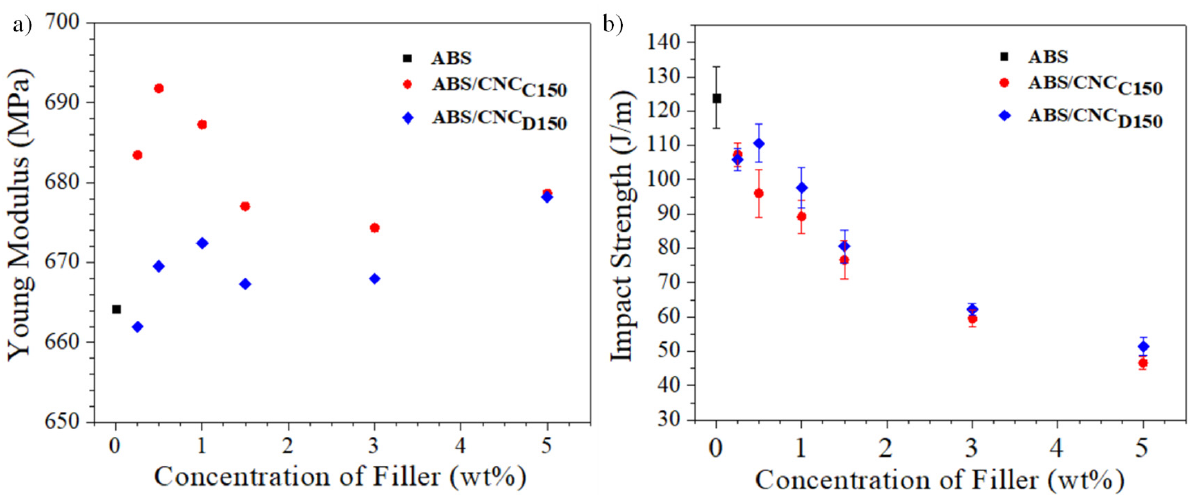
Figure 9. Young’s modulus ( a ) and impact strength ( b ) of ABS/ m- CNCs nanocomposites.